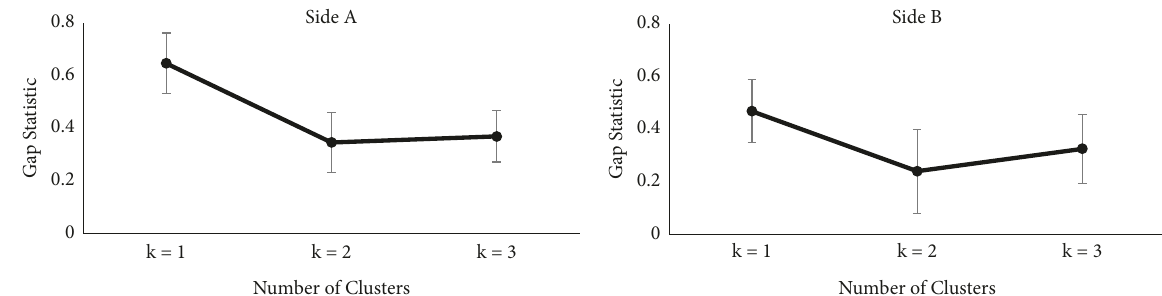
Figure 4: Average gap values for k=1, 2, and 3 for pass locations from table side A (right) and table side B (right). The largest gap value indicates the optimal number of clusters [14].